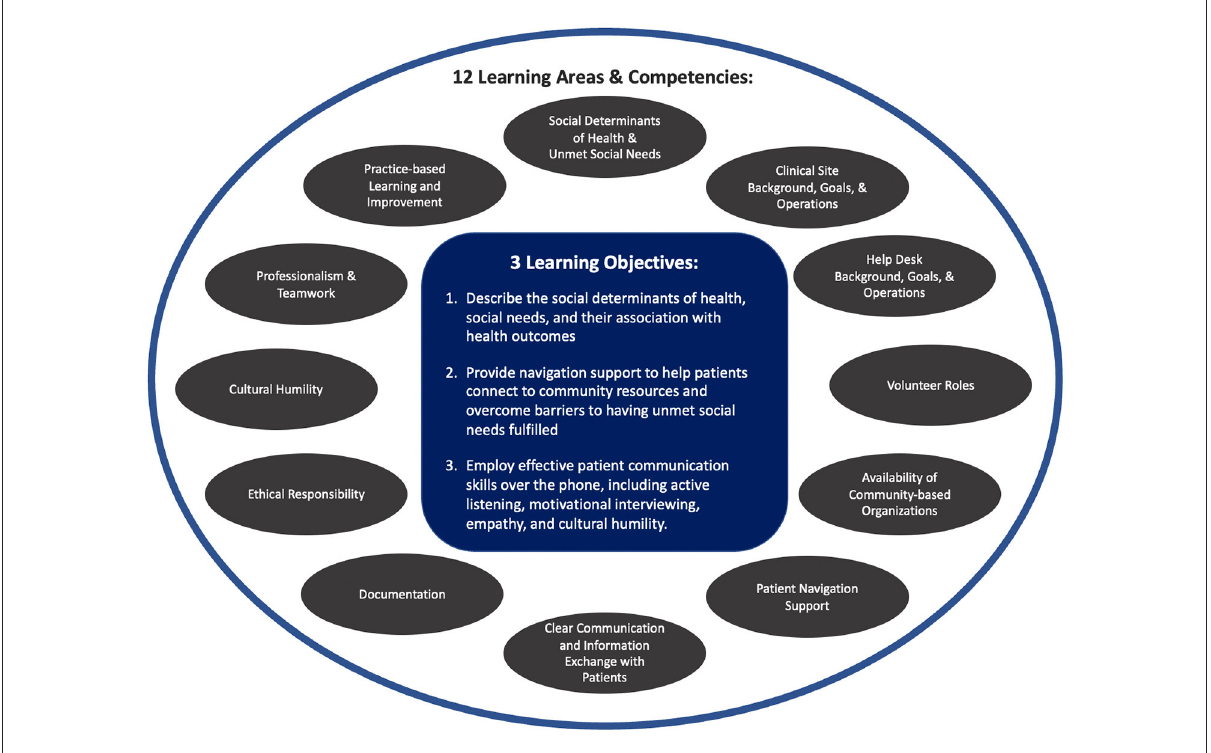
FIGURE1 Help desk learning objectives and learning